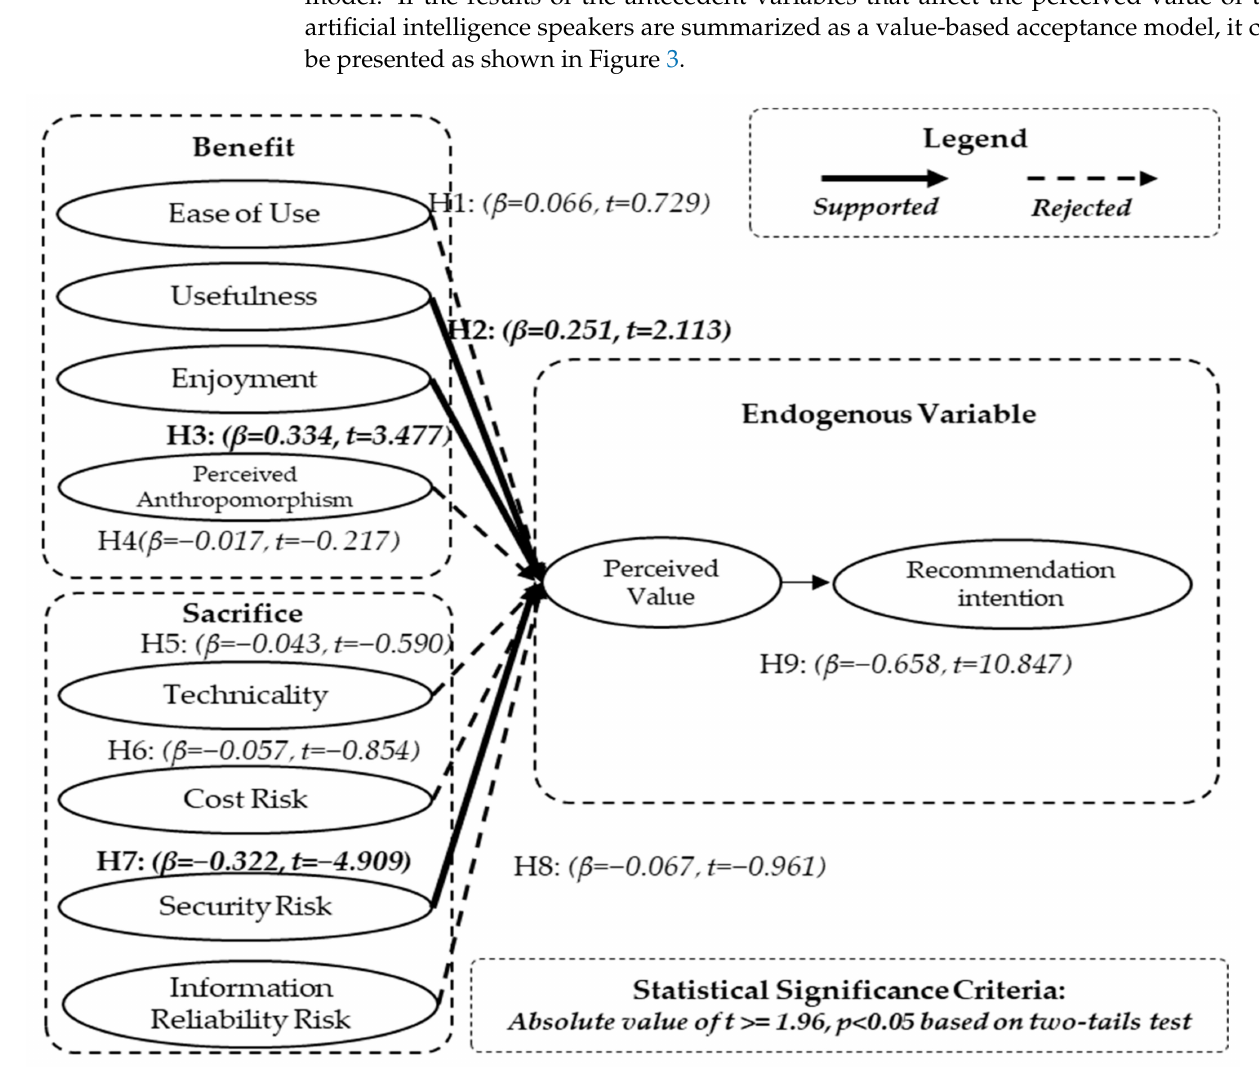
Figure 3. VAM applied artificial intelligence speaker regression analysis